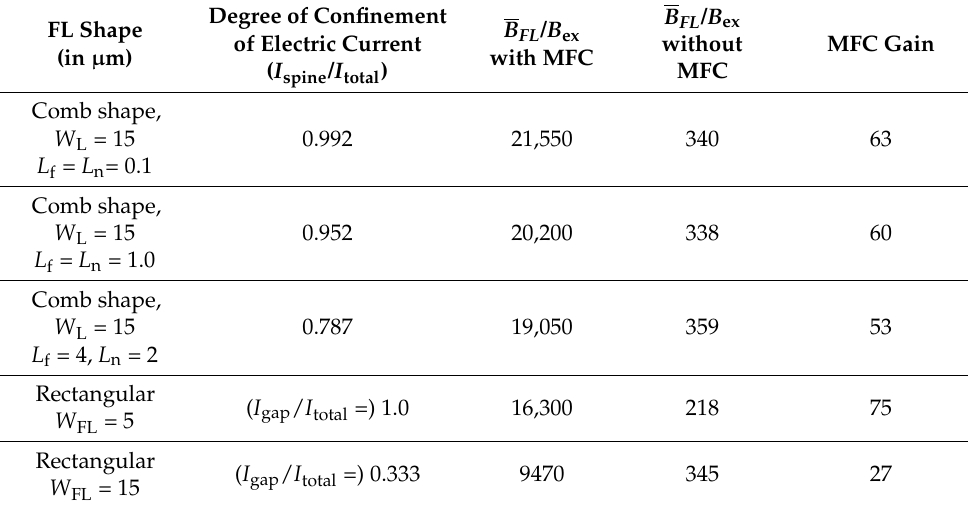
Table 1. Degree of confinement of the electric current, B ̅ FL / B ex with and without MFC, and MFC gain in different FLs with a constant W L = 15 µ m and different L f and L n . The values for the rectangular FL with W FL = 5 and 15 μ m are also given for comparison. For simulations, the MFC gap was fixed to W G = 5 μ m.